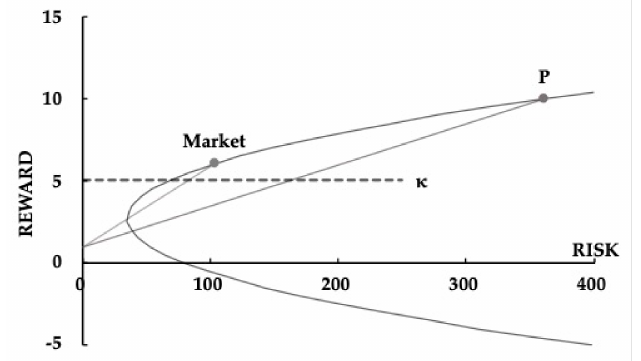
Figure 3. Risk comparison between bond-stock